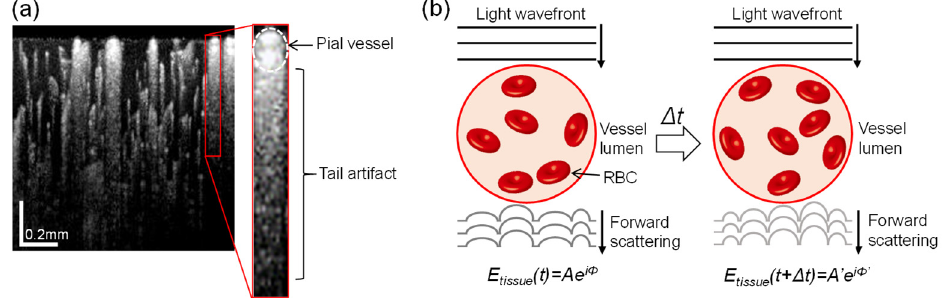
Figure 1. ( a ) An example of a log-scaled cross-sectional OCT angiography (OCTA) image of a mouse cerebral cortex. Inset is an enlargement showing a vertical streak (tail) trailing behind a superficial pial vessel. ( b ) Schematic illustration of the principle behind tail artifacts in OCTA images: changes in the position and density of red blood cells (RBCs) during flow over time causes variance in the forward-scattered wavefront of the light field arriving at the stationary tissue, resulting in spurious graphic artifacts behind the blood vessel during OCTA processing.